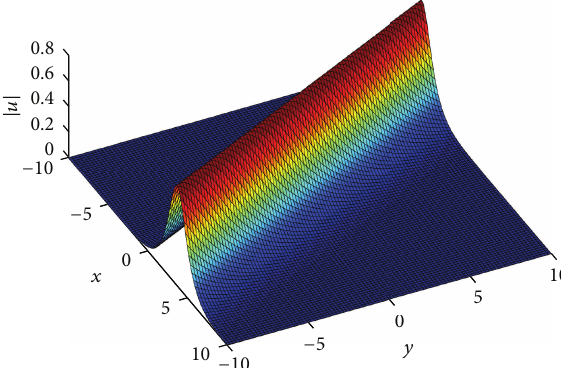
= 𝜅 = 0.5 , 𝛽 = 𝜅 = 1 , 𝛼 = 1 , 𝑡 = 1 . 1 1 2 2